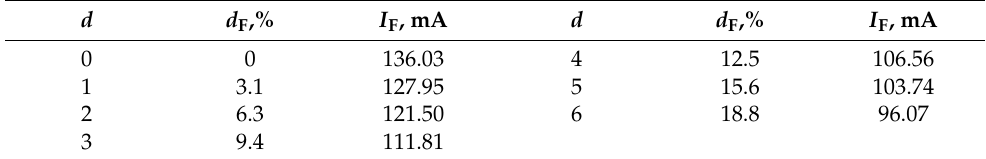
Table 5. Results of experiments for FIR (finite impulse response) filters.